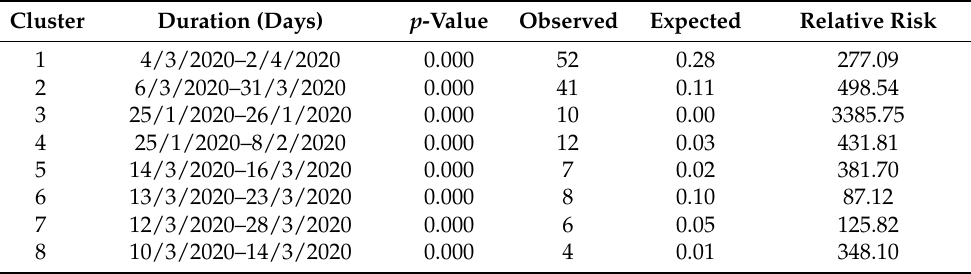
Table 6. Space–time clusters in stage I of COVID-19 transmission in non-residential locations in Hong